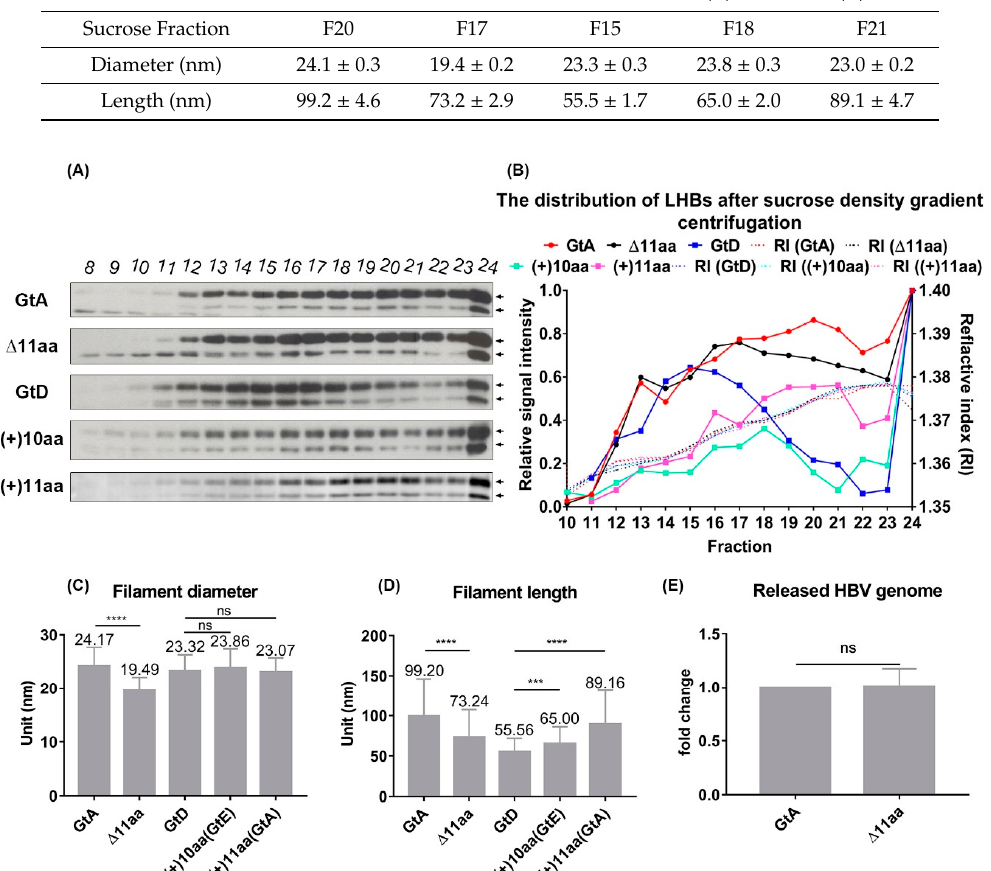
Figure 4. The presence of GtA-derived 11 aa promotes the generation of abundant longer filaments. ( A , B ) Polyethylene glycol (PEG)-concentrated supernatants from Huh7.5 cells overexpressing the genome GtA, GtD and the derivatives were analyzed by 10–30% ( w/w ) discontinuous sucrose gradient ultracentrifugation. A total of 24 fractions were harvested and fractions 10 to 24 were analyzed by refractive index, as well as Western blot using the PreS1-domain-specific monoclonal MA18/7. The signal of LHBs was measured by Image studio lite and the signal from fraction 24 was standardized as 1. ( C , D ) Filament-rich fractions (F20 in GtA, F17 in GtA_ ∆ 11aa, F15 in GtD, F21 in GtD_(+)11aa(GtA) and F18 in GtD_(+)10aa(GtE)) were analyzed by electron microscopy (EM). The size (diameter and length) of more than 80 filaments (101 in GtA, 136 in GtA_ ∆ 11aa, 87 in GtD, 108 in GtD_(+)11aa(GtA) and 81 in GtD_(+)10aa(GtE)) was measured by an EM-specific software Radius (EMSIS). ( E – H ) HBsAg-containing particles from Huh7.5 cells overexpressing GtA, GtD and the derivatives were precipitated by 10% PEG and then purified by sucrose ultracentrifugation followed by qPCR (E,F) and EM (G,H). (G) The diameter of more than 20 virions (47 in GtA, 92 in GtA_ ∆ 11aa, 90 in GtD, 42 in GtD_(+)11aa(GtA) and 22 in GtD_(+)10aa(GtE)) was measured by an EM-specific software Radius (EMSIS). *, p < 0.05; **, p < 0.01; ***, p < 0.001, **** p < 0.0001